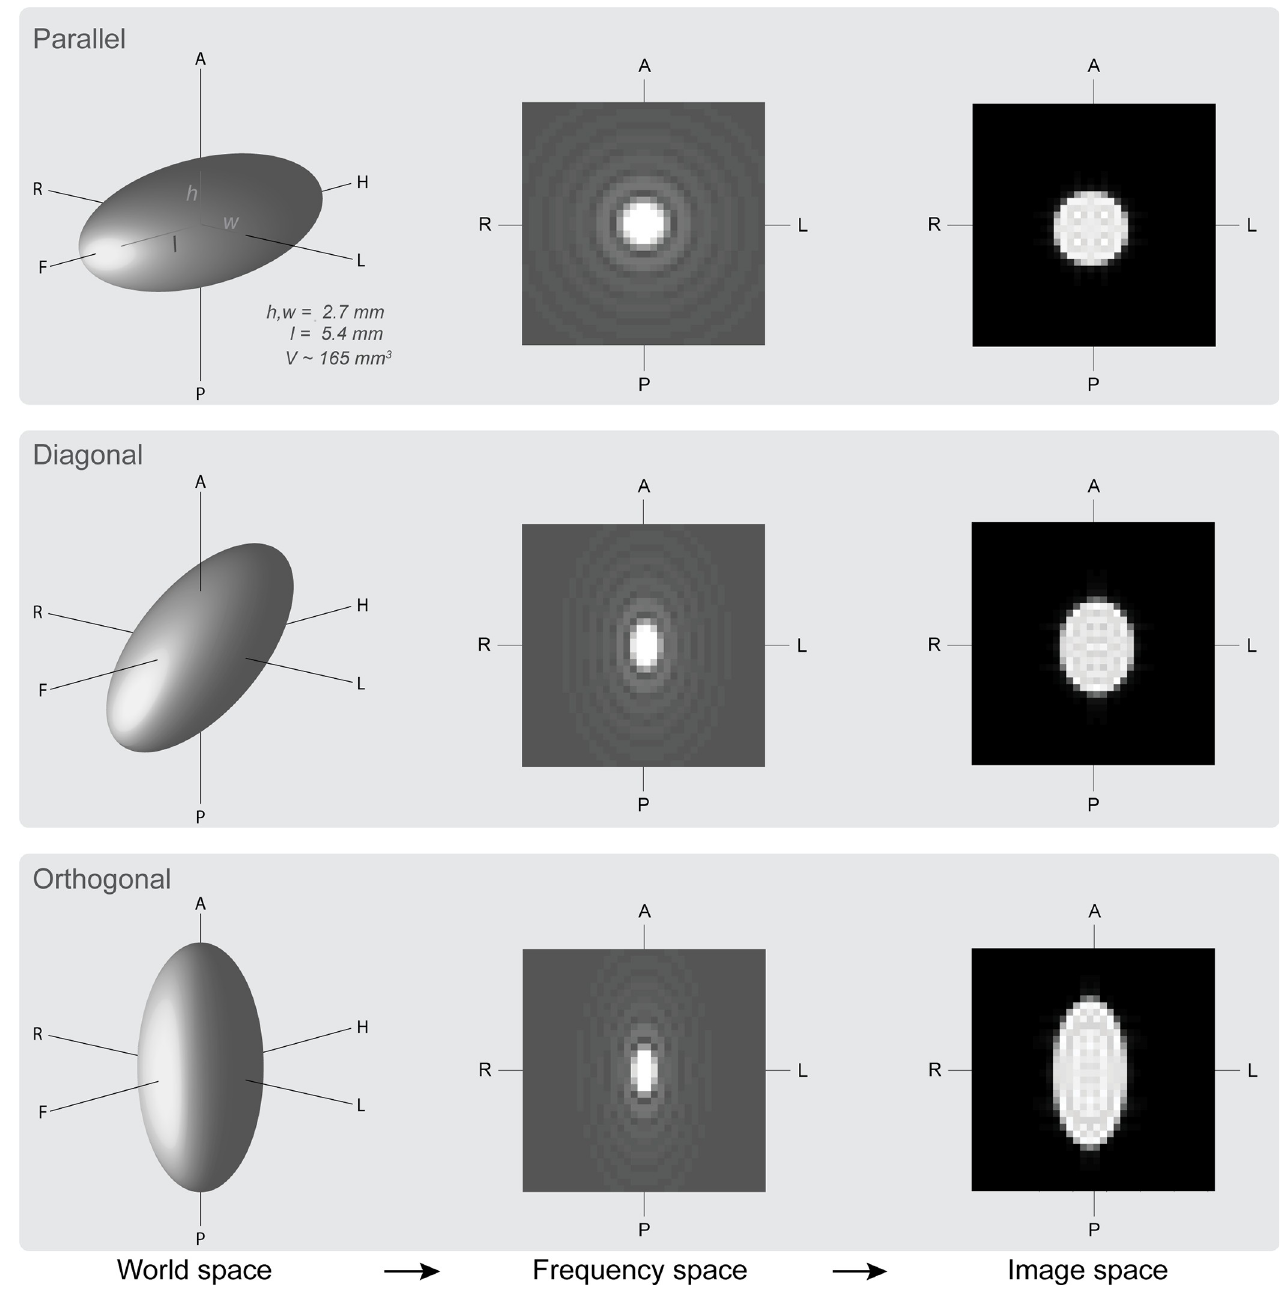
Fig 1. Simulation pipeline. Representation of the simulations in which ellipsoids in world space are reconstructed into MR volumes of different resolutions (image space). Orientations were chosen to resemble circumstances in the MRI scanner. The in-plane ( x , y -dimension) resolution corresponds to a slice acquired along the scan-direction H-F (slice axis z ). Anisotropy (slice thickness) was varied across the slice axis. The long axis of the ellipsoids was either placed parallel, diagonal or orthogonal to the slice axis. Figs for both frequency and image space represent the mid-slice of the reconstructed volume from sagittal view. Here reconstructed images were simulated with a voxel size of 0.5mm isotropic. A = anterior; F = feet; H = head; h = height; L = left; l = length; P = posterior; R = right; V = volume; w = width.